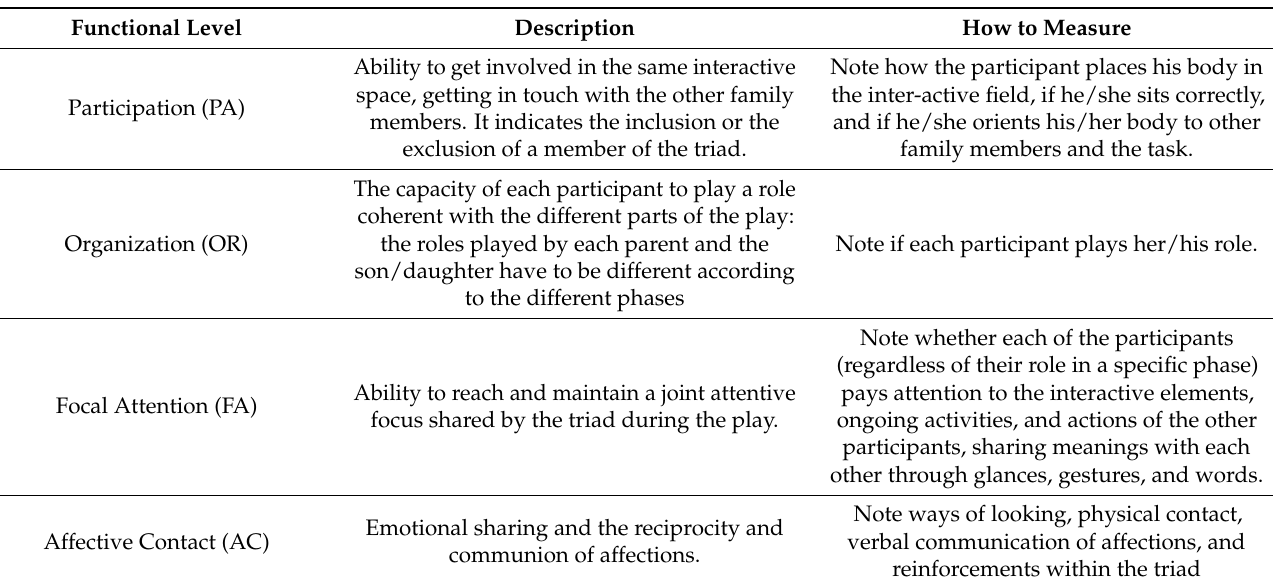
Table 2. LTPc functional